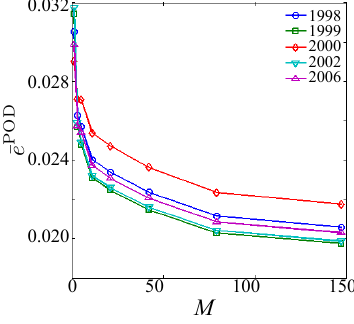
Figure 16. The probability density function (PDF) of f , f POD - MM 1x g and f POD - MM3 for day 20 for year 1998 at site A for which 1x g e POD - MM3 is approximately equal to ¯ e POD - MM3 ; 1x g = 1x g 1x g